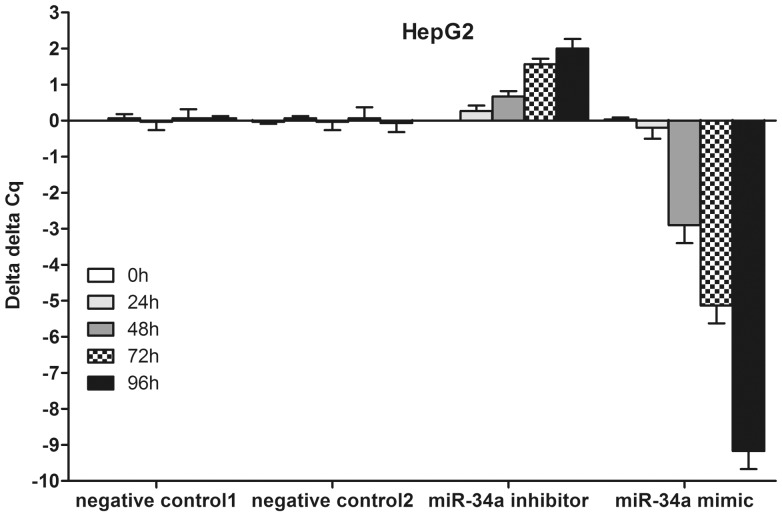
Transfection efficiency of miR-34a inhibitor and miR-34a mimic in HepG2 cells.HepG2 cells (2.5×104 cells per well using 6-well-plate) were transfected with miR-34a inhibitor, miR-34a mimic and their negative controls up to 96 h. Expression of miR-34a was detected using real time RT-qPCR and delta delta Cq was calculated.